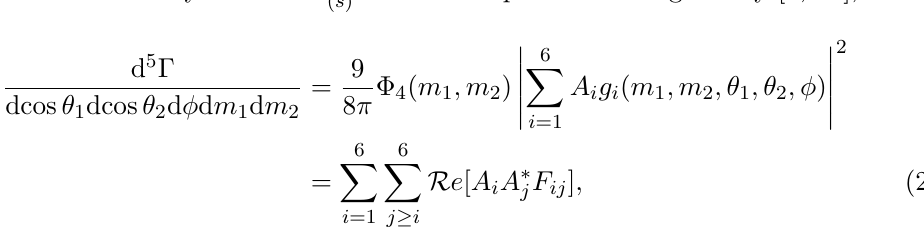
Table 1 . Parameters of the mass propagators employed in the amplitude analysis. The di(cid:11)erential decay rate for B 0 mesons 3 at production is given by [6, ( s )